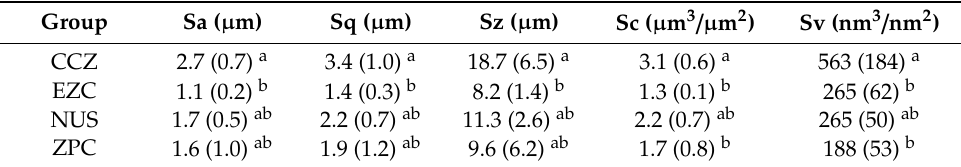
Figure 1. Representative 3D-optical profilometric images from all tested groups: ( A ) CCZ, ( B ) EZC, ( C ) NUS, and ( D ) ZPC. All surfaces demonstrate parallel striations and machining tracks. Please note the differences in scales. Table 2. Mean values and standard deviations in parentheses along with the statistical outcome of all tested groups.